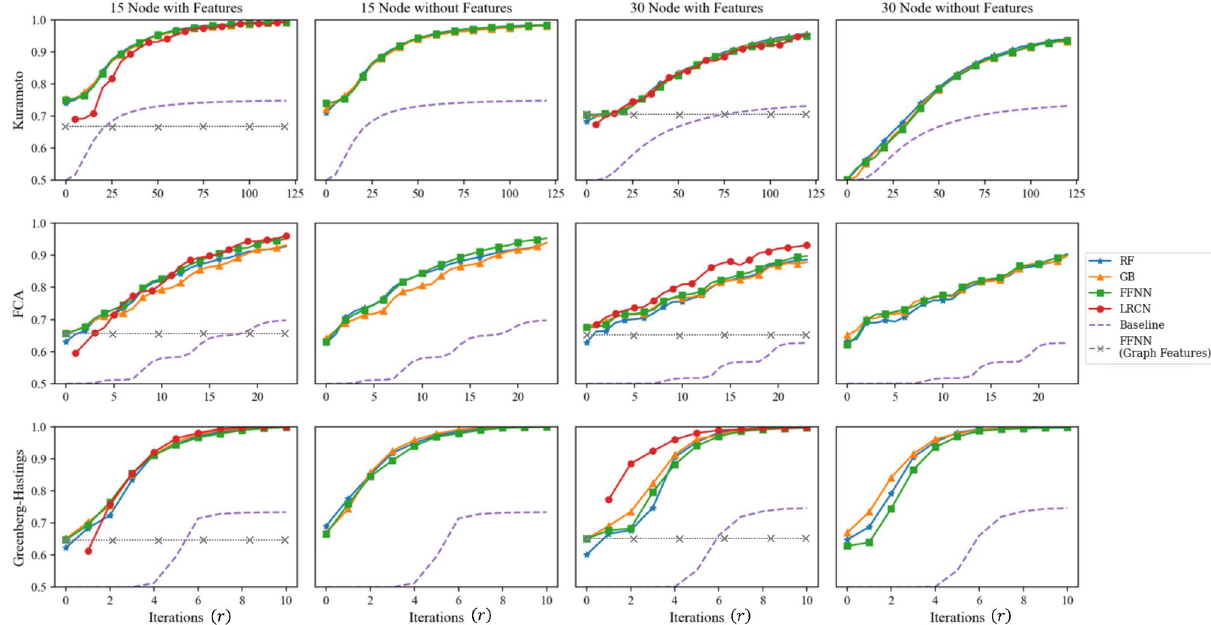
Figure 5. Synchronization prediction accuracies of four machine learning algorithms for the KM, FCA, and GHM coupled oscillators synchronization. For each of the six datasets in Table 2, we used 5-fold cross- validation with 80/20 split of test/train. Accuracy is measured by the ratio of the number of correctly classified examples to the total number of examples. Algorithms for the second and the fourth columns are trained only with dynamics up to various iterations r indicated on the horizontal axes, whereas the other two columns also use additional graph features. r = 0 in the ”with Features” columns indicates the input consisting of initial phase configuration X 0 and its quartiles paired with the five graph statistics of number of edges , min degree , max degree , diameter , number of nodes . The gray dashed line represents training FFNN only on the five graph statistics. Hence its accuracy is constant with respect to the varying number of training